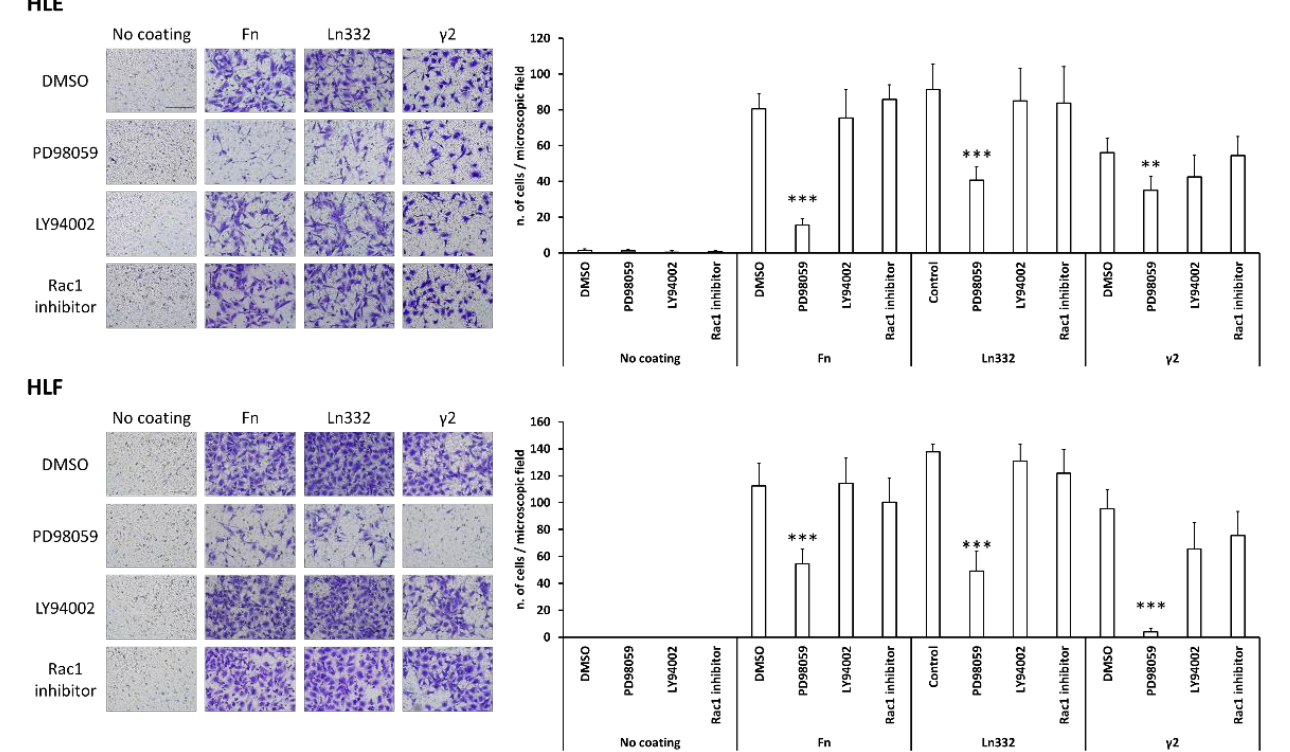
Figure 4. Migration of HCC cells to fibronectin, Ln332, and Ln332 γ 2 chains depends on the activation of ERK1/2. HLE and HLF cells were seeded on the top of the transwell membrane, previously coated with Fn, or Ln332, or γ 2, on the lower side and allowed to migrate for 16 h in culture medium serum free with vehicle (DMSO, diluted 1:286 vol/vol), MEK inhibitor (PD98059, 50 µ M), AKT inhibitor (LY294002, 25 µ M), or active Rac1 inhibitor (CAS 117786517-6, 50 µ M). Data are the means ± SD of five randomly chosen microscopic fields. T test (unpaired, two-tailed): ** p < 0.01, and *** p < 0.001 vs. control (DMSO) of related ECM protein coating condition. Scale bar = 100 µm.